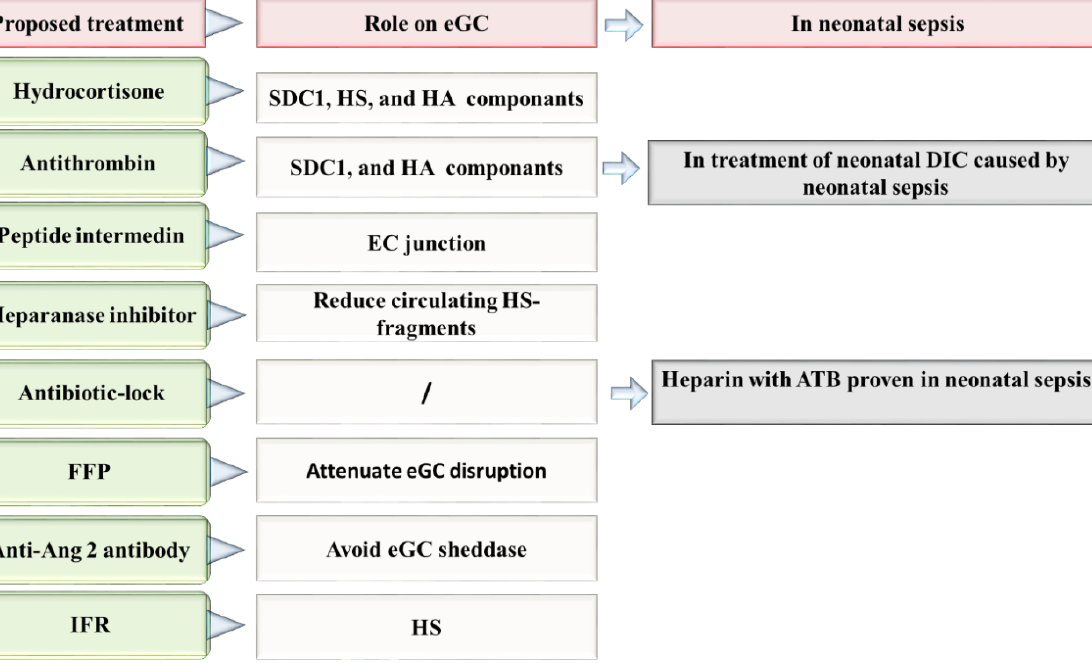
Figure 3. Proposed therapies directed to the repair of eGC in neonatal sepsis. Ang 2: